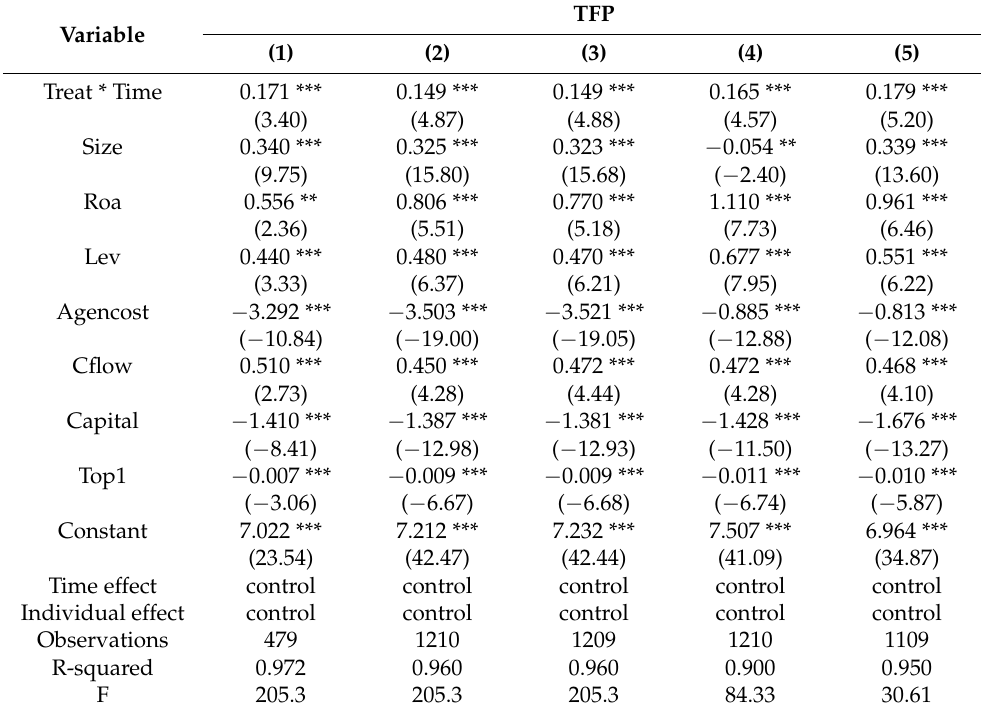
Table 5. Robustness